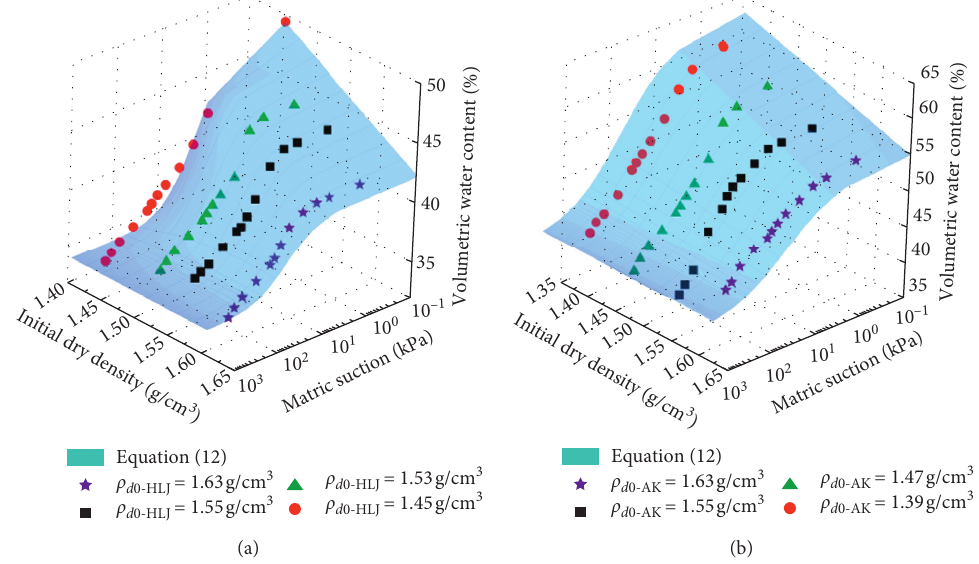
Figure 11: The three-dimensional fitting results under different initial dry densities: (a) HLJ soil and (b) AK soil.